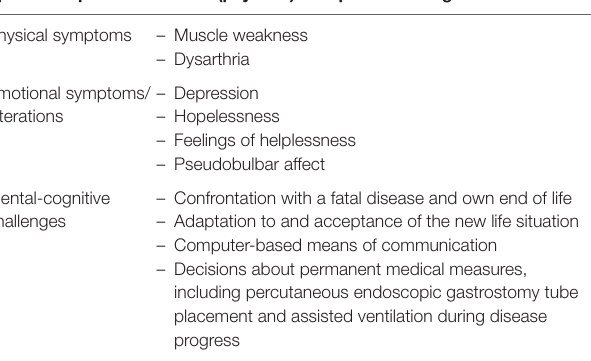
specific aspects of ALs for (psycho-)therapeutic